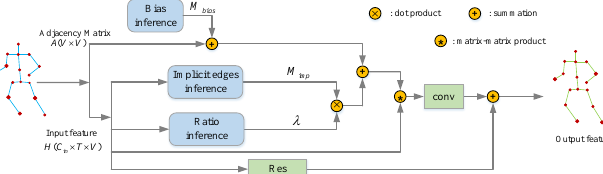
Figure 2. The illustration of the action-specific Graph Convolution Module. H is the input feature with the size of C in × T × V . A ∈ R V × V is the adjacency matrix. The implicit edges inference will produce the implicit connections M imp . The ratio inference is also implemented by Equation (4). It will learn a weight λ to decide the ratio of M imp . M bias is the learnable matrix as the bias, which is produced by bias inference. These three matrixes will be added together as the adjacency matrix of graph convolutional layer. The matrix–matrix product followed by conv denotes the graph convolution operation. The output dimension of this module will not be changed in spatial dimension and temporal